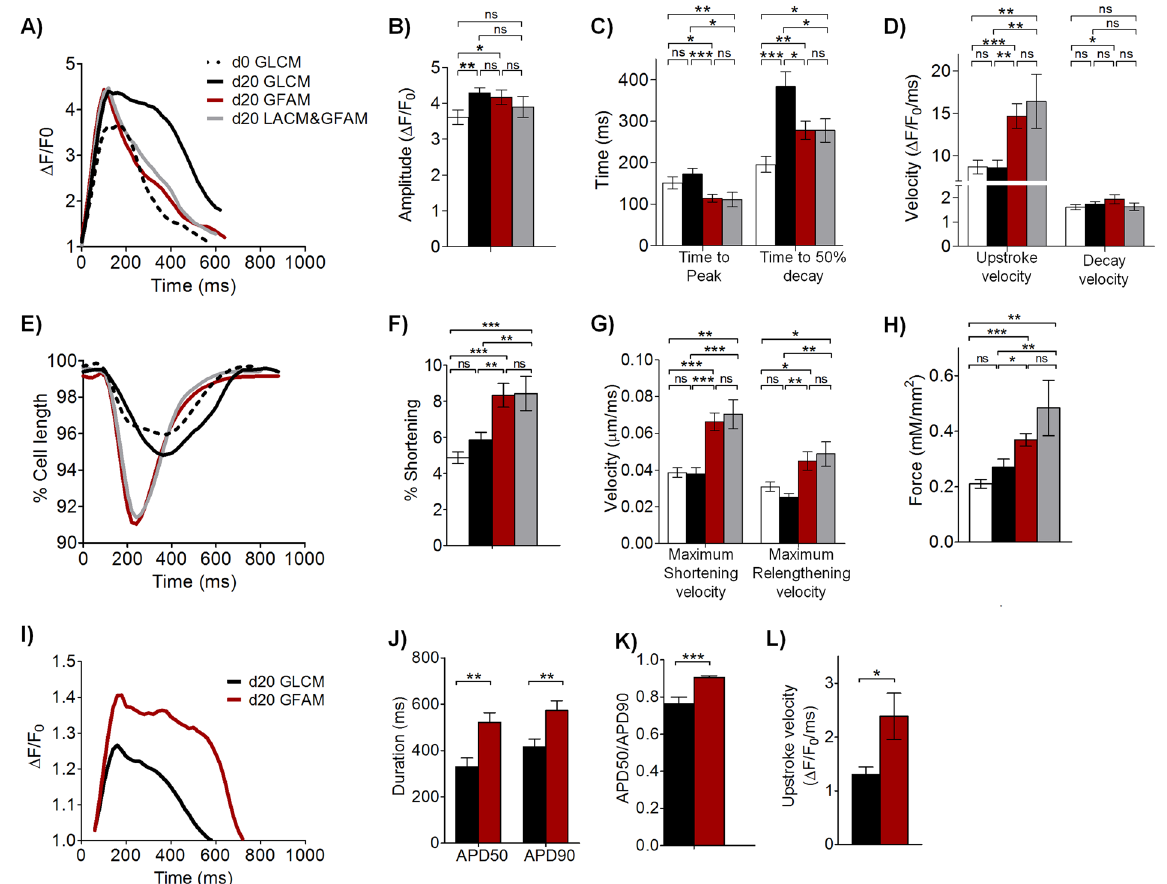
Figure 6. Impact of metabolic manipulation on hiPSC-CM functionality. hiPSC-CMs were analyzed in terms of calcium transients ( A – D ), contractile performance ( E – H ) and action potential (AP) kinetics ( I – L ), before (d0) and after 20 days (d20) of culture in different media. Calcium transient kinetics ( A – D ) evaluated with the intracellular calcium indicator Fluo-4 AM: ( A ) Representative calcium transient; ( B) Calcium transient amplitude (F/F0); ( C ) Time to peak and time to 50% decay; ( D ) Average upstroke and decay velocities. n = 28–35 cells per condition from 3 separate experiments. ( E ) Representative contraction curves, reflecting changes in the percentage of cell length. ( F ) Percentage of shortening; ( G ) Maximum shortening and relengthening velocities. n = 20–35 cells per condition. ( H ) Maximum contractile force generated by hiPSC-CMs in each culture condition. n = 8–17 cells per condition from 3 separate experiments. AP kinetics (I–L) were determined with a voltage-sensitive dye (FluoVolt). ( I ) Changes in the fluorescence intensity of the FluoVolt AP indicator over time. ( J ) AP duration at 50% (APD 50 ) and 90% repolarization (APD 90 ). ( K ) APD50/APD90. ( L ) AP upstroke velocity. n = 24–26 cells per condition from 3 separate experiments. Data are represented as mean ± SEM. * p < 0.05; ** p < 0.01; *** p < 0.001; ns, not